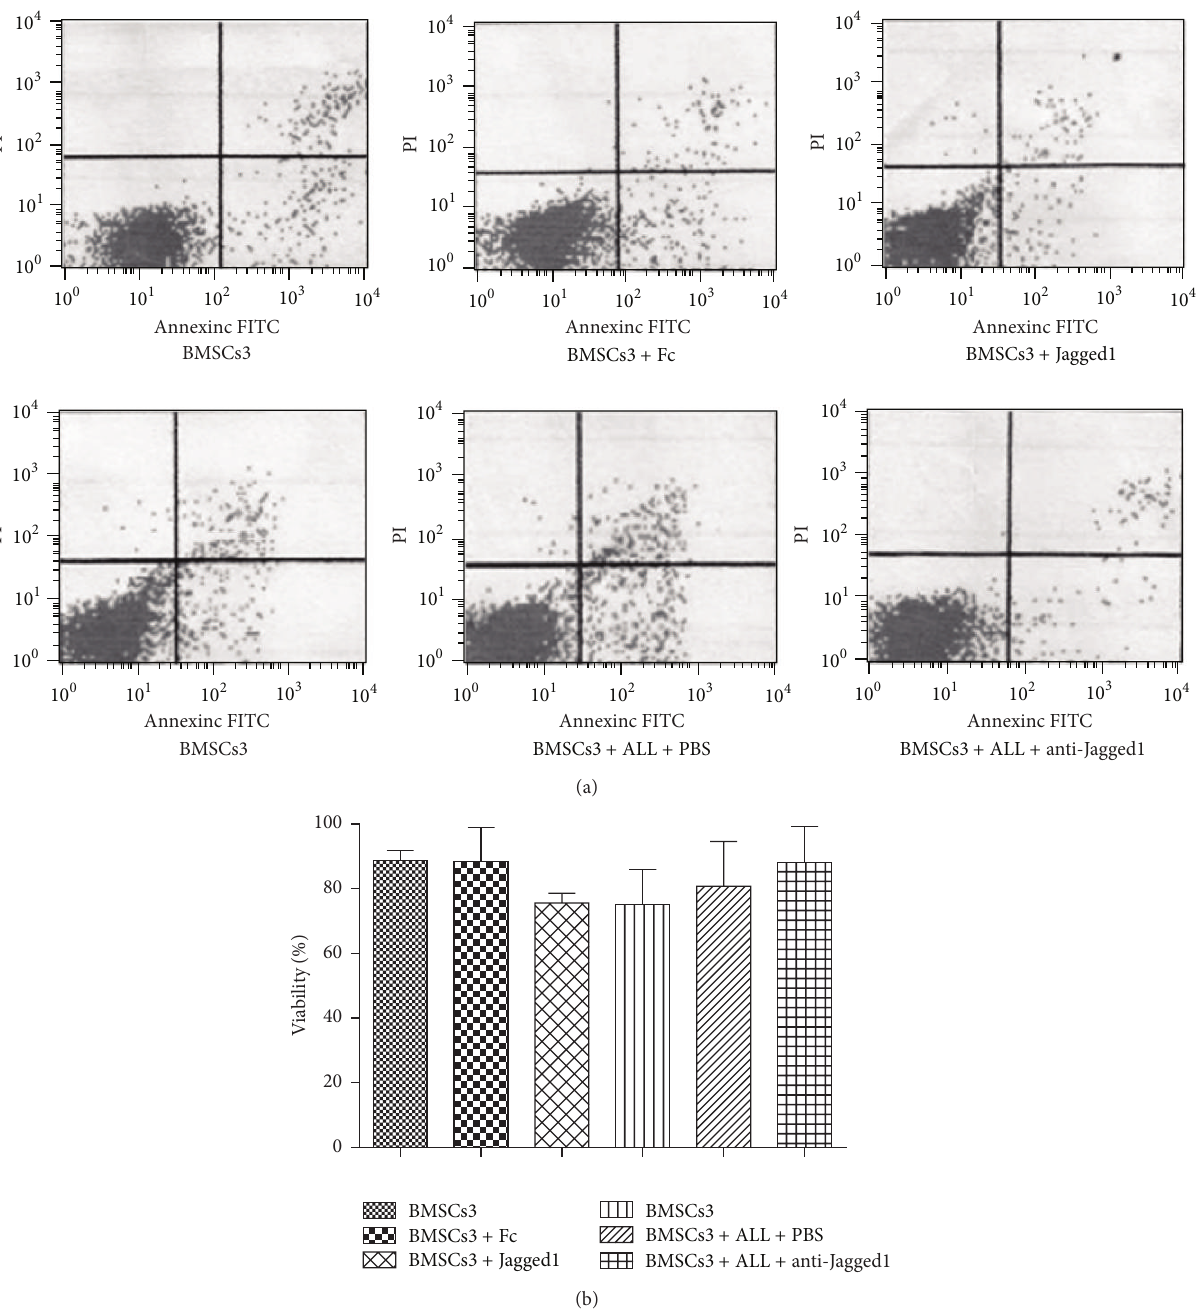
Figure 5: No toxic and apoptotic effect on BMSCs in the Jagged1 treatment. (a) The presence of both death and apoptotic BMSCs has been investigated by flow cytometry after 3 days in the presence and absence of recombinant Notch ligand Jagged1 or anti-Jagged1 neutralizing Ab. (b) The viability of BMSCs in the Jagged1 treatment using a cytotoxic assay after 14 days.